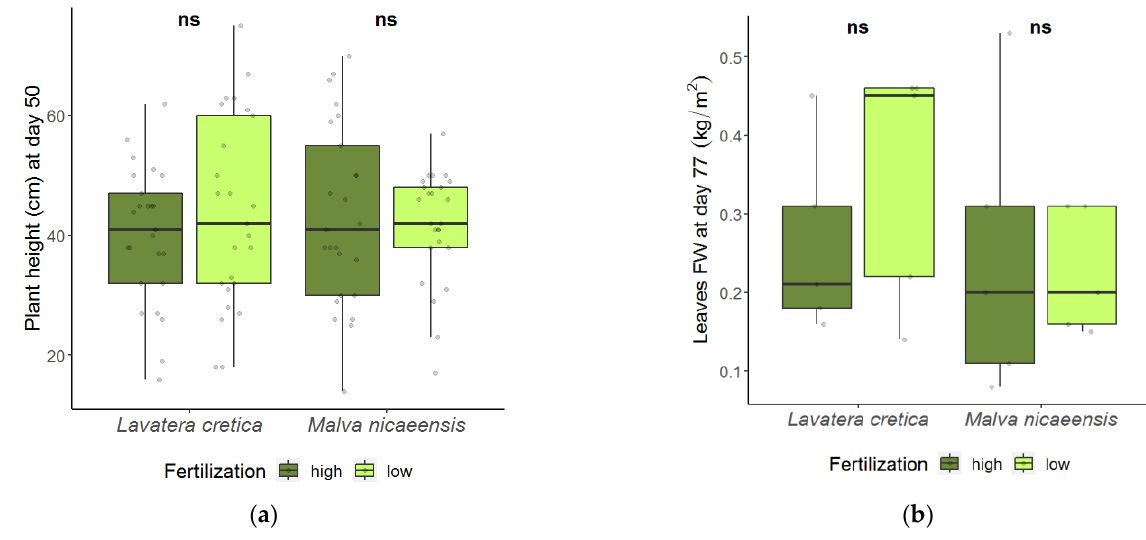
Figure 2. Development of L. cretica and M. nicaeensis in nitrogen (N) enrichment net house experiment (2020 – 2021). High and low indicates fertigation with 180 ppm and 120 ppm, respectively. Each dot represents an individual plant; dots are distributed horizontally for visual clarity. Median is indicated as a horizontal line within the box plot. ( a ) Plant height after 50 days; ( b ) Leaf FW per m 2 after 77 days. ns stands for Not Statistically Significant.